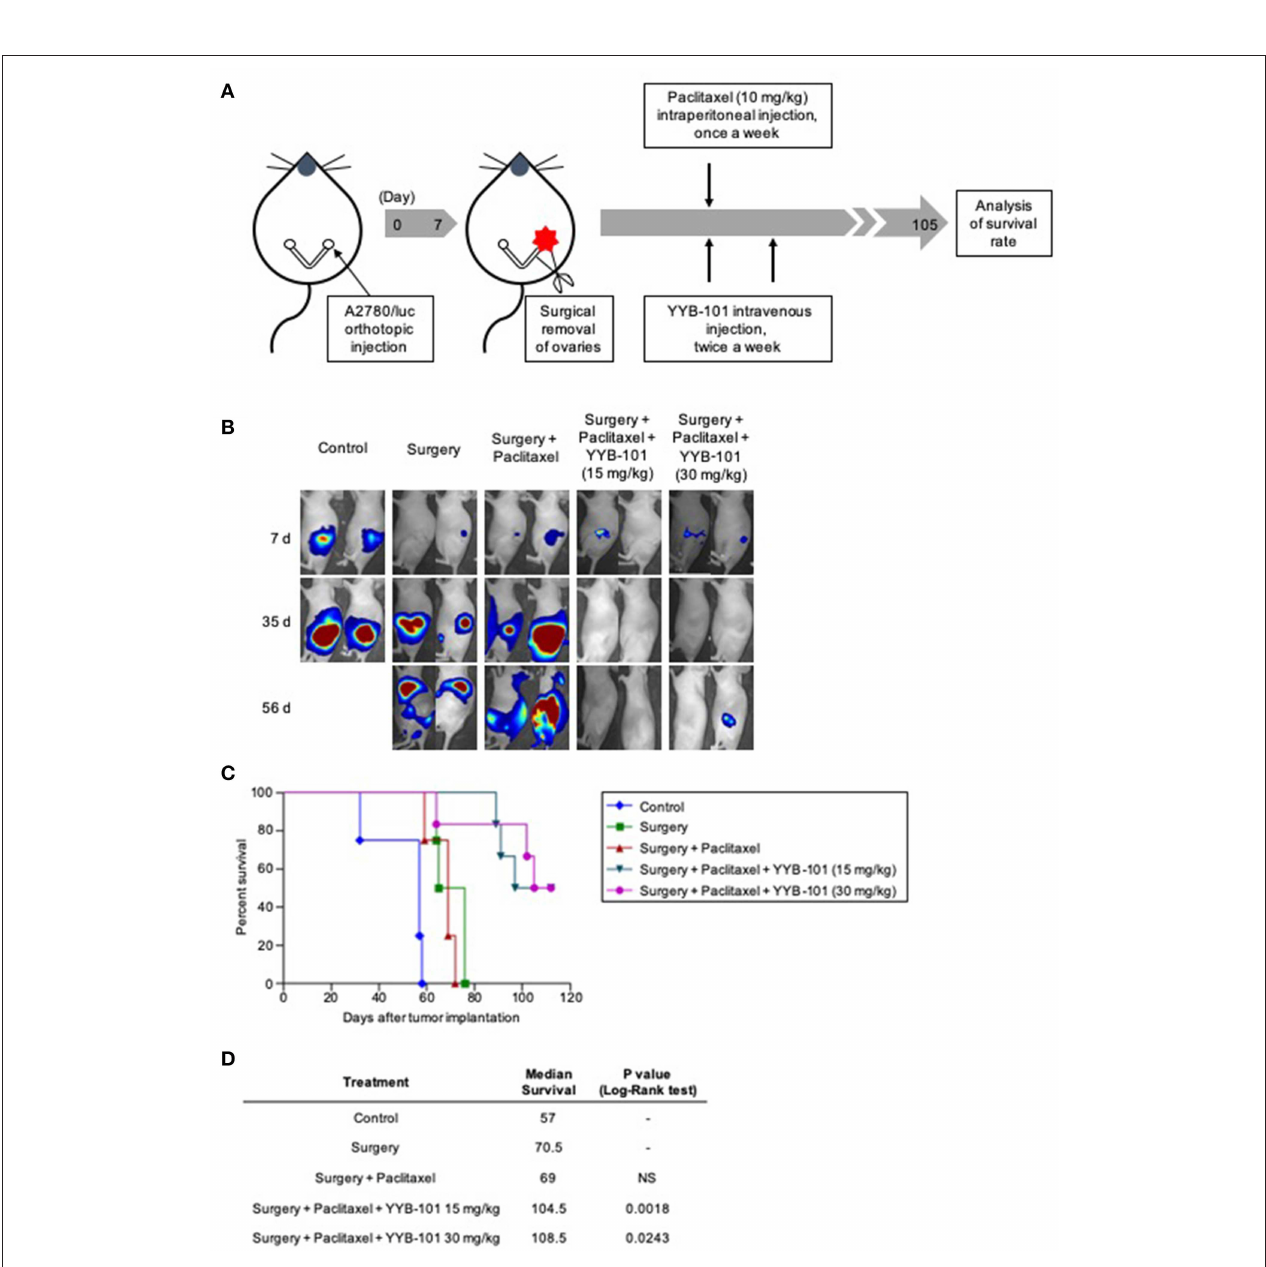
FIGURE 5 | Image software. Error bars represent ± standard error of the mean (SEM). The t -test p -value was the comparison between co-treatment with control group (** p < 0.01). (D) Kaplan-Meier analysis of survival of various groups of mice for up to 100 days after cancer cell implantation. (E) Median survival was calculated using Kaplan-Meier statistic. Log-Rank, p < 0.001 for paclitaxel and combination treatment groups compared with control group. (F) Body weight change of mice for 30 days after tumor implantation. Values represent the mean ± standard deviation (SD). Average body weight of drug treatment groups was not significantly different compared with control group.